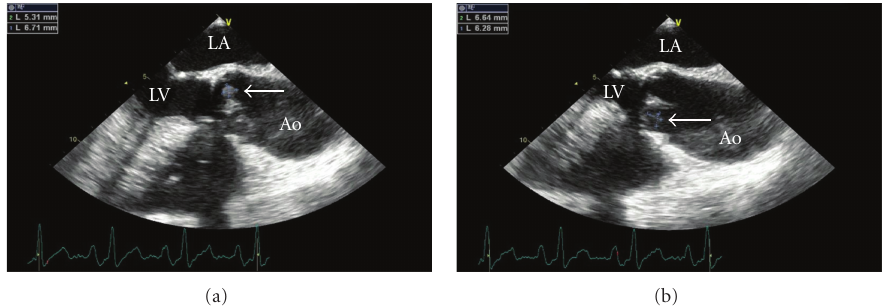
Figure 2: Transesophageal echocardiography. Echodense images on the aortic cups indicated by arrows. Left atrium (LA), left ventricle (LV), aorta (Ao).